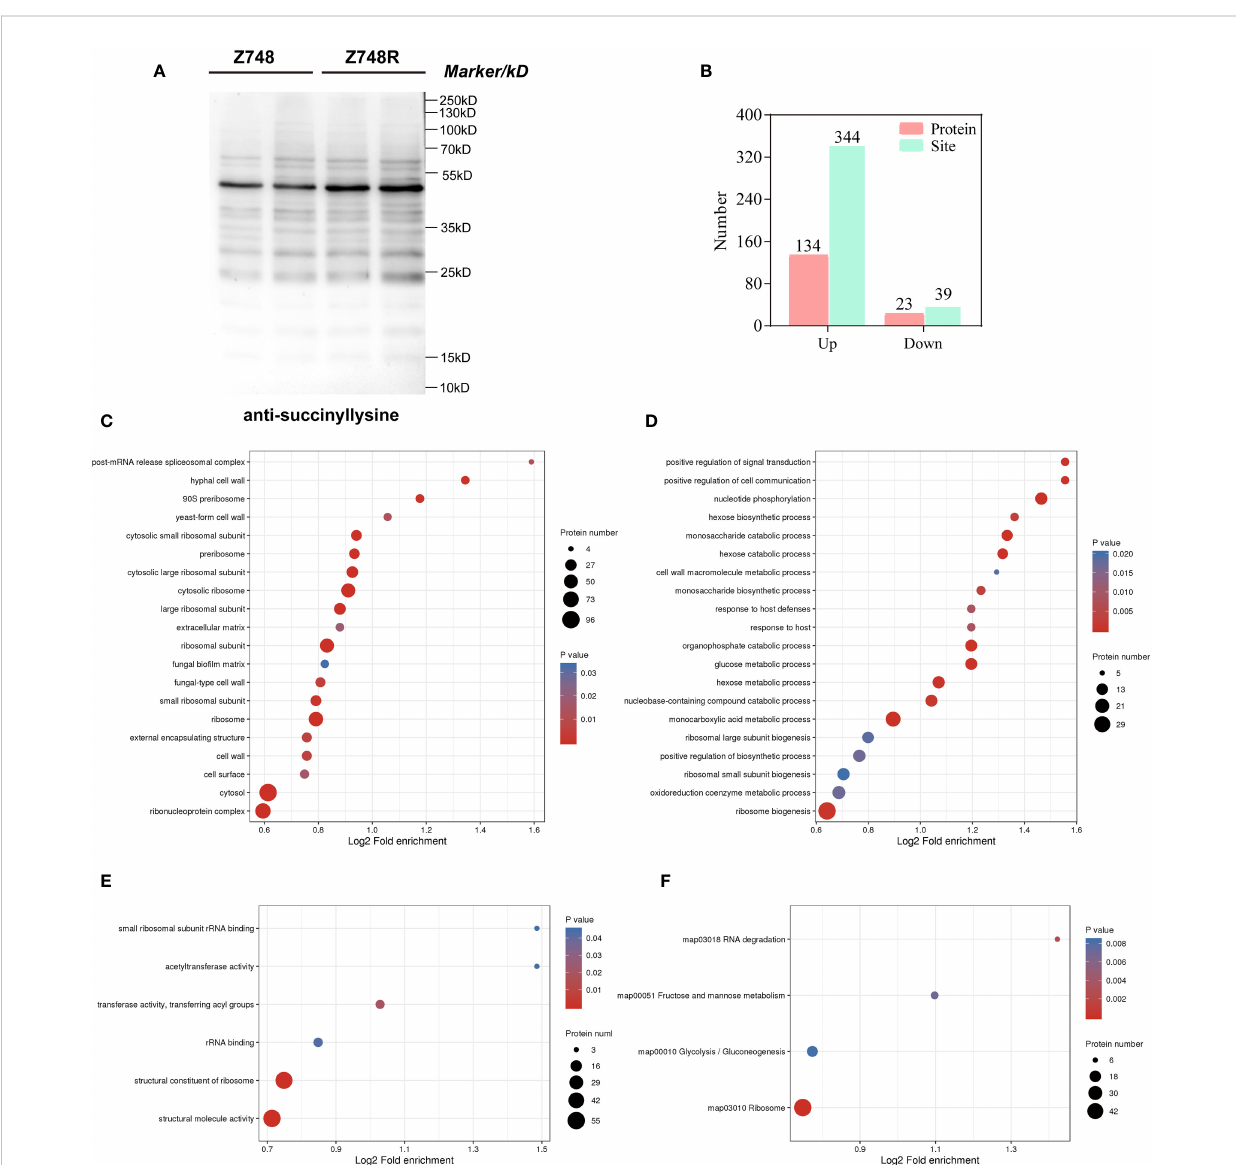
FIGURE 2 Comparative succinylation analyses between Z748 and Z748R. (A) WB analysis showed increased expression of lysine succinylation in Z748R. (B) Differentially expressed lysine succinylated proteins and sites. (C – E) GO enrichment analysis of differentially expressed succinylated proteins, including cellular components (C) , biological processes (D) , and molecular functions (E) . (F) KEGG pathway enrichment analysis of the differentially expressed succinylated